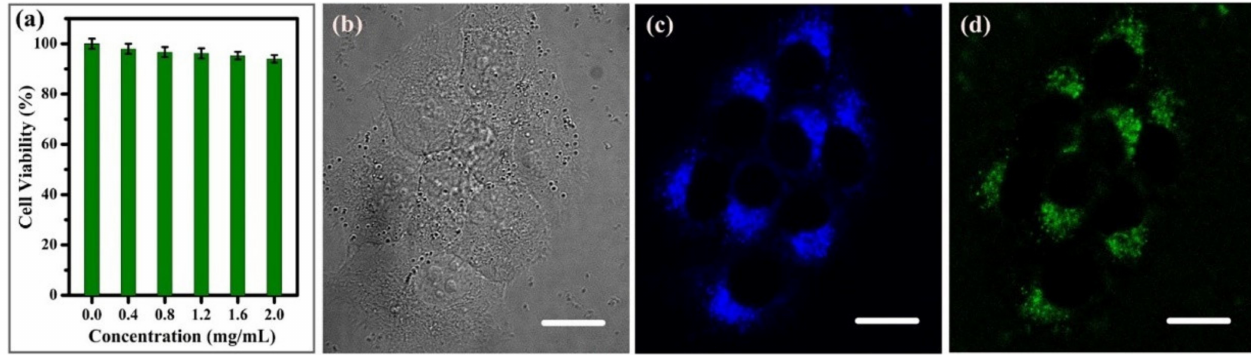
Figure 9. ( a ) The effect of CDs on Bcap-37 cell viability (MTT assay). Confocal fluorescence micropho- tographs of CDs labeled Bcap-37 cells under a bright field ( b ) at the excitation wavelengths of 405 nm ( c ) and 488 nm ( d ). All scale bars are 20 µ m [104].